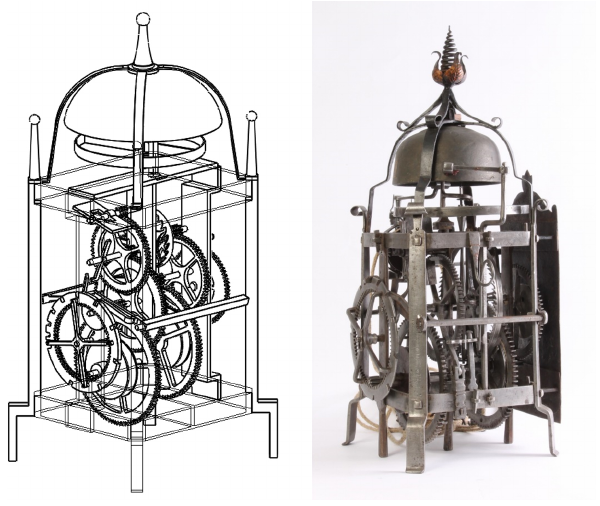
Figure 13. N4 – South-German iron Gothic clock (Toebosch An- tiques,